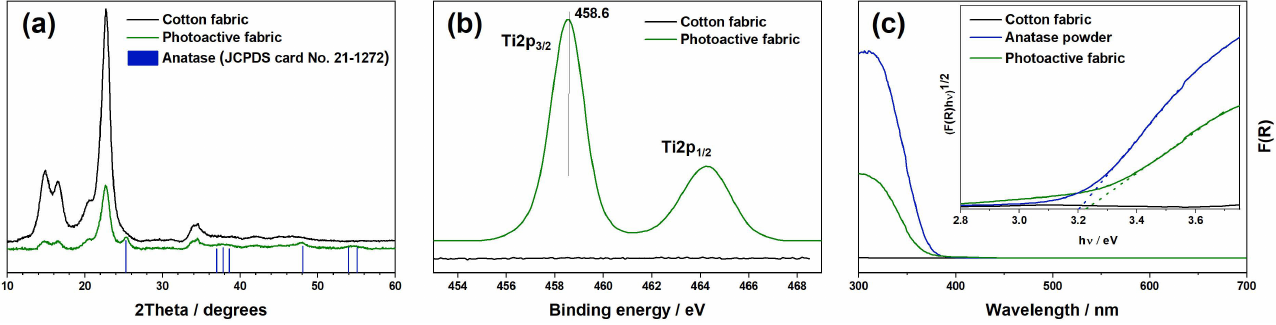
Figure 2. XRD patterns ( a ), X-ray photoelectron spectra ( b ), and UV-Vis absorbance spectra ( c ) of pristine cotton fabric and prepared photoactive fabric. The inset in ( c ) shows corresponding Tauc plots.